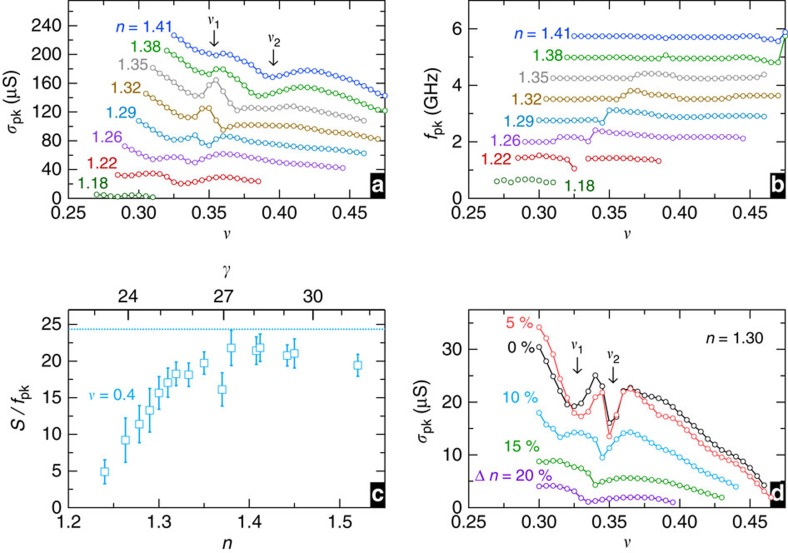
Electron density and Landau filling dependence of resonance parameters.(a) The resonance peak conductivity, σpk, versus ν for many n successively offset by 20 μS. (b) The peak frequency fpk versus ν for the same n as (a) successively offset by 0.5 GHz. Spectra were taken at ν intervals of 0.005. We denote the lower and higher ν minima, respectively, by ν1 and ν2. (c) S/fpk versus n, where S is the integrated Re (σxx) versus f for the resonance, for ν=0.4 (where the integration is performed for 0.1<f<1.5 GHz). Conversion to γ is plotted on the top axis. The error in S/fpk is calculated as the difference between the measured value and that obtained by fitting the resonance to a Gaussian. The dotted line marks the theoretical value15
S/fpk=πe2ν/2h for full-charge carrier participation. Except near n=1.38, at which S/fpk is suppressed, the curve increases before saturating at ∼85% of the theoretical value. The observed increase in S/fpk demonstrates increase in the strength of the bilayer solid with increasing n as the available particles contribute to the solid. (d) The peak resonance σpk versus ν at fixed n=1.30. Here the well is imbalanced by asymmetric gating to transfer charge Δn between the two layers.